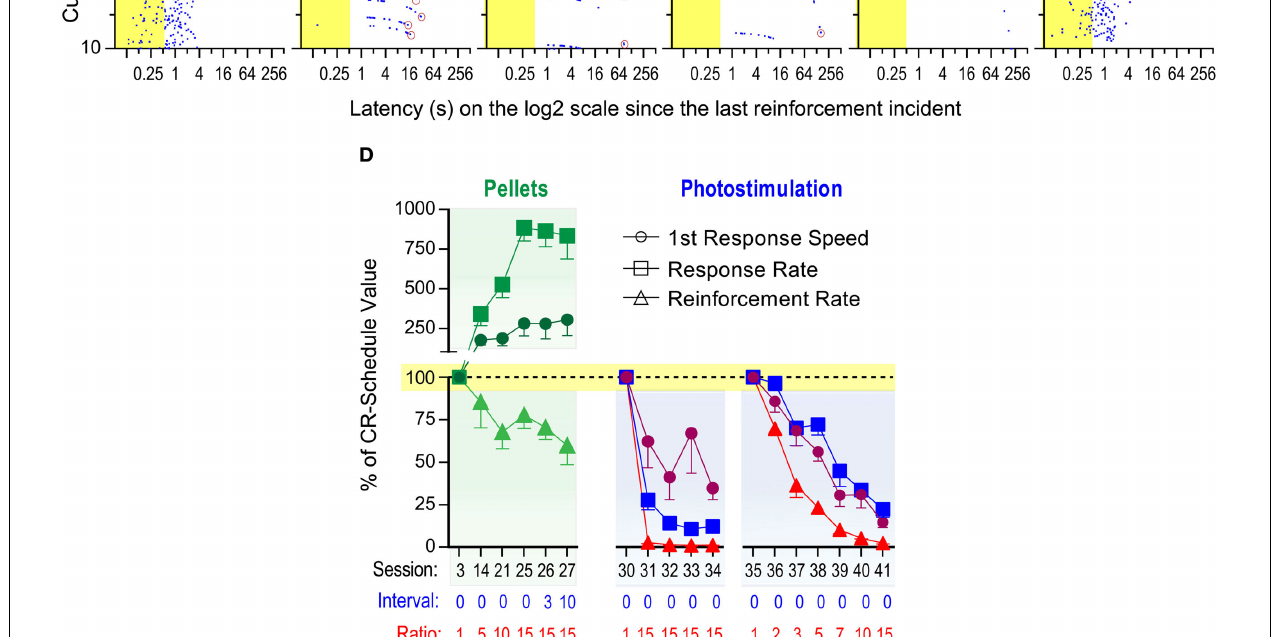
FIGURE 7 | Effects of fixed ratio schedules on responses reinforced with food pellets or photo-pulse trains. Fixed-ratio (FR) schedules reinforce lever pressing after a completion of a fixed number of presses counted from the